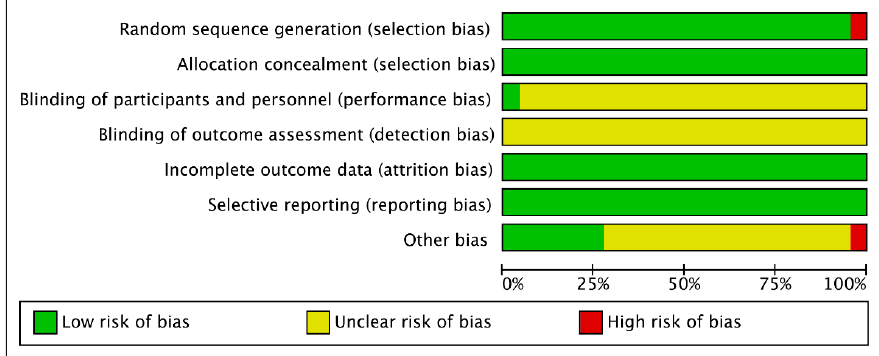
Figure 2. Risk of bias graph (each item presented as percentages).